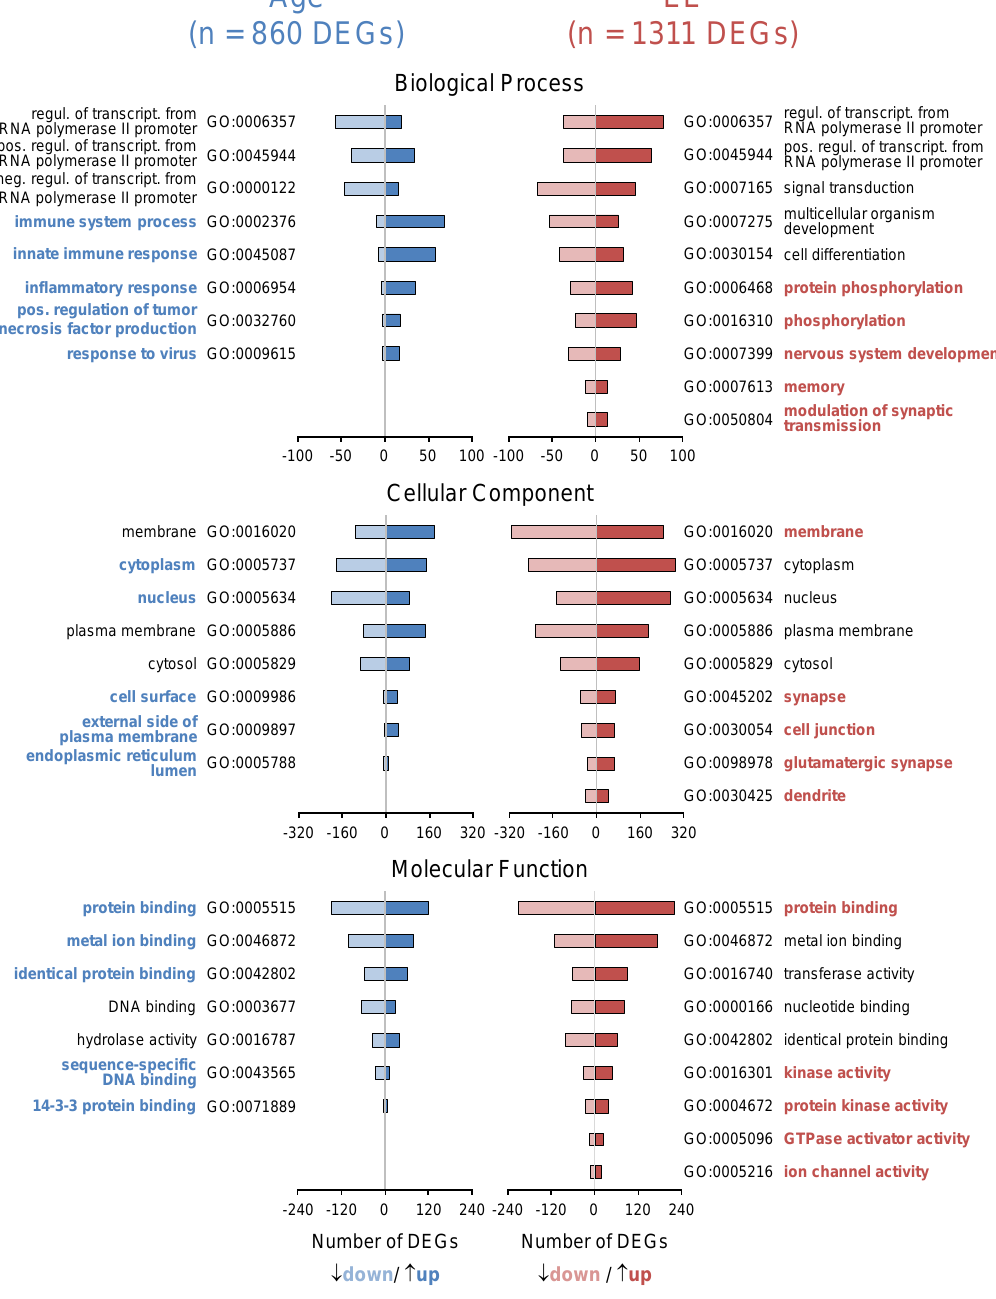
Figure 2. Late-onset EE affects hippocampal gene expression more than age. Aging in standard housing conditions revealed n = 860 DEGs (5mSC vs. 24mSC, left side in blue) whereas late-onset